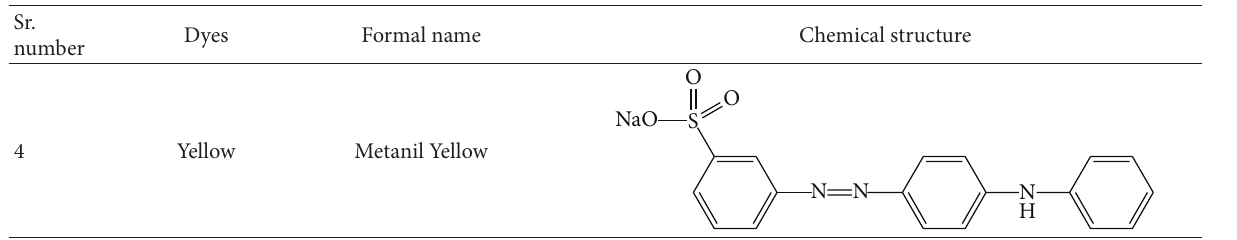
Table 2: Phytotoxicity test of different treated and untreated textile dyes. Maize Sorghum Treatments Plumule (cm) Radicle (cm) Plumule (cm) Radicle (cm) Control (irrigation water) 20 ±